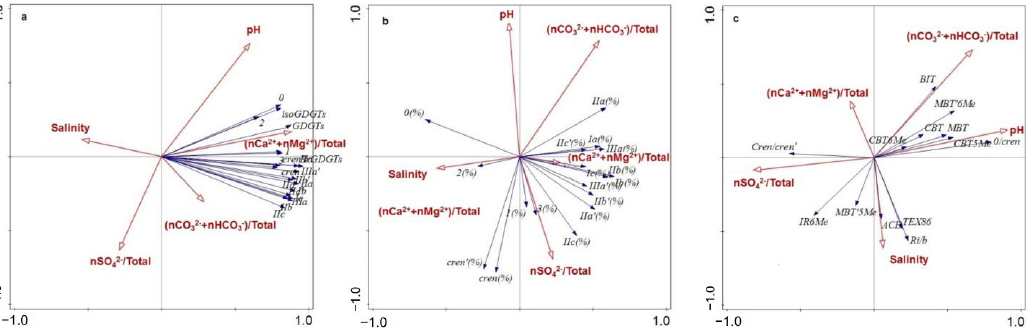
Figure 5. Redundancy analysis of the relationships between hydrochemical parameters with ( a ) GDGT concentrations, ( b ) GDGT distributions, and ( c ) GDGT-based indices.